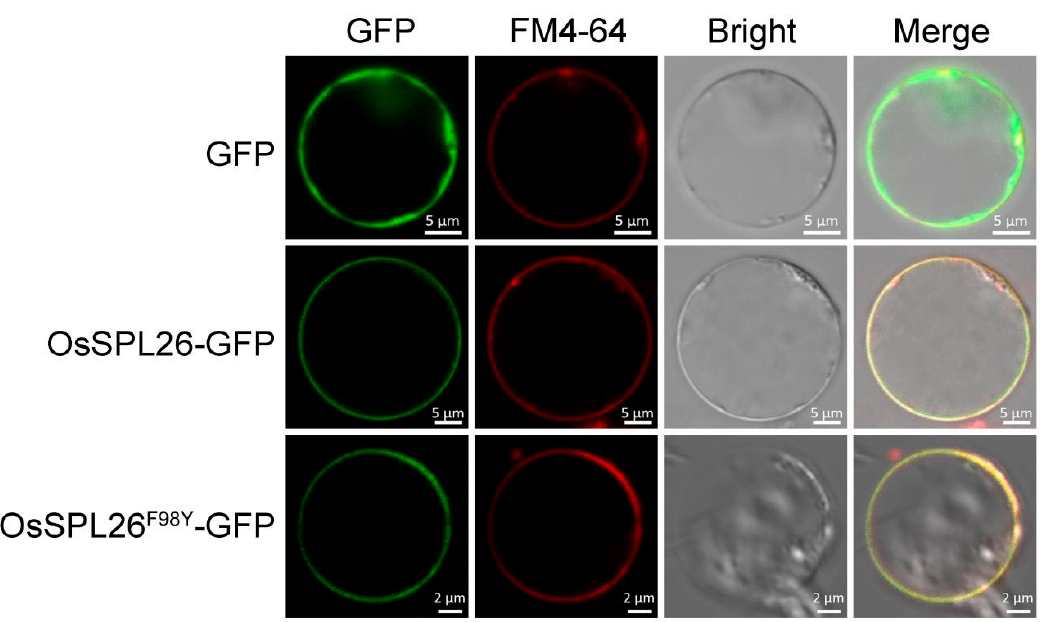
Figure 4. Subcellular location of OsSPL26-GFP in rice protoplasts. The red dye FM4-64 is used as a marker of plasma membrane localization. Upper panel: control GFP, Middle panel: OsSPL26 fused to GFP, Lower panel: OsSPL26 F98Y fused to GFP. GFP, Green fluorescence protein